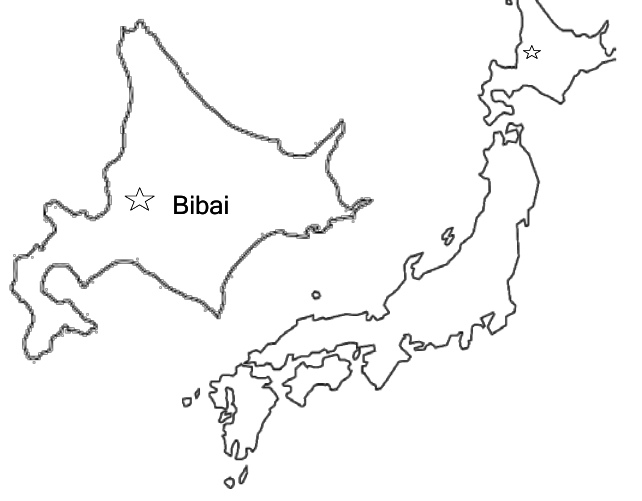
Figure 1. Investigated sites.